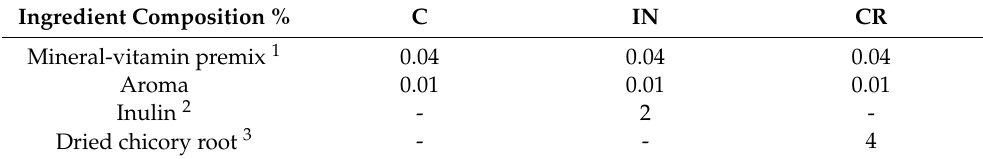
Table 1. Cont. Ingredient Composition